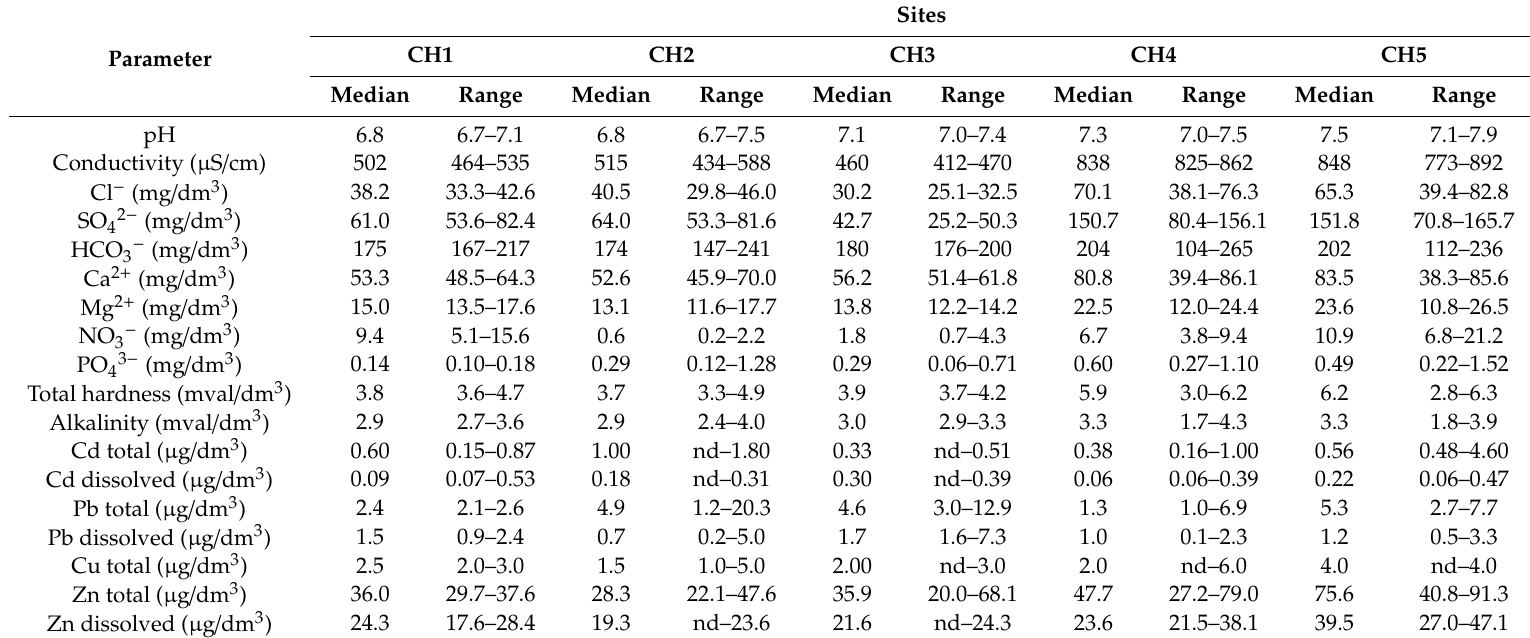
Table 1. Physico-chemical parameters (median, range) of the waters of the subsidence